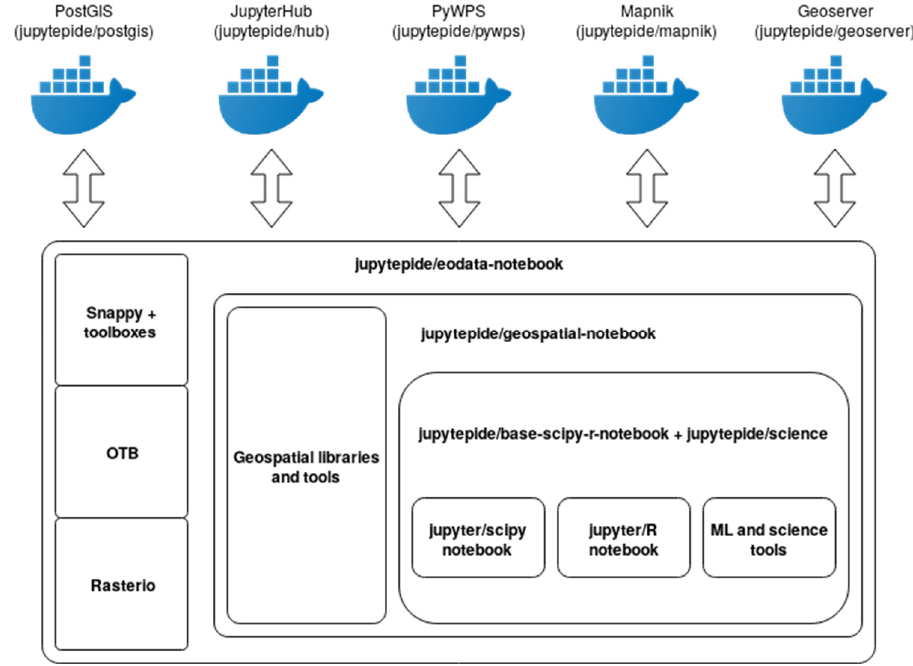
Figure 4. JupyTEP IDE architecture with service components in the form of Docker containers.